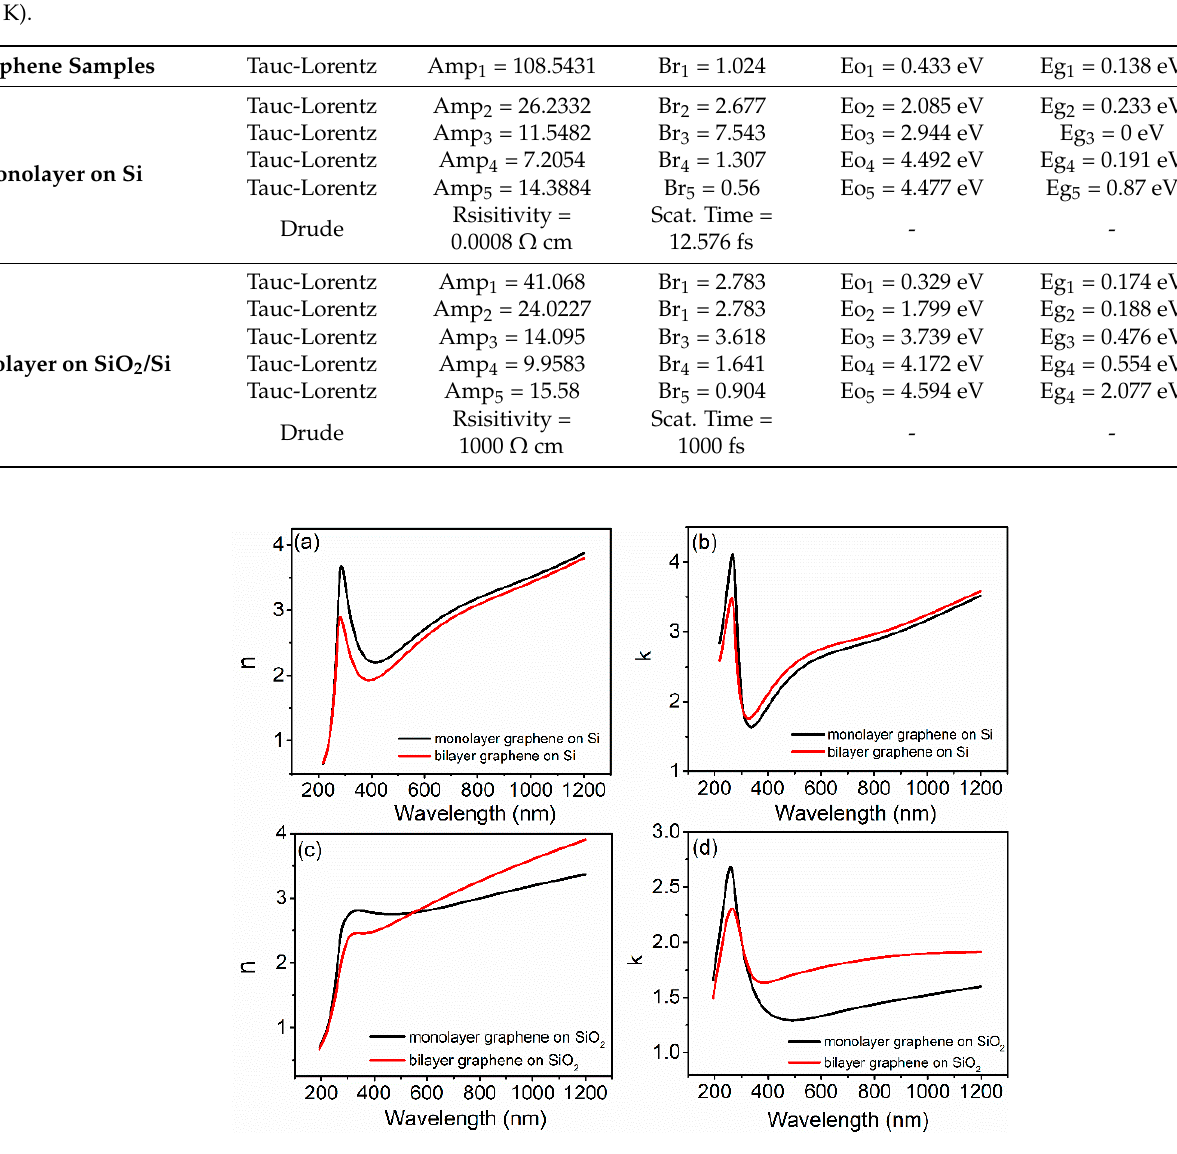
Figure 4. Layer-dependent optical constants of graphene on Si [( a ) and ( b )] and on SiO 2 /Si substrate [( c ) and ( d )].